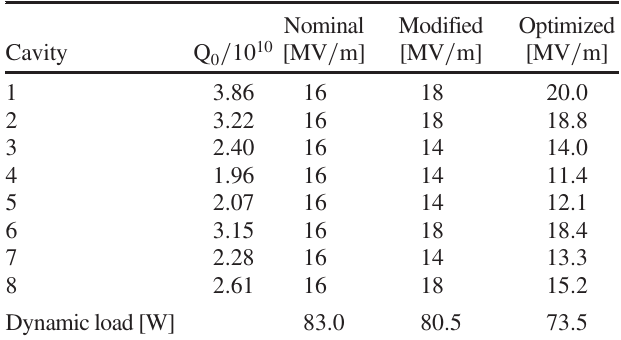
TABLE I. Example to illustrate cavity-by-cavity adjustment of the gradient to minimize dynamic load.